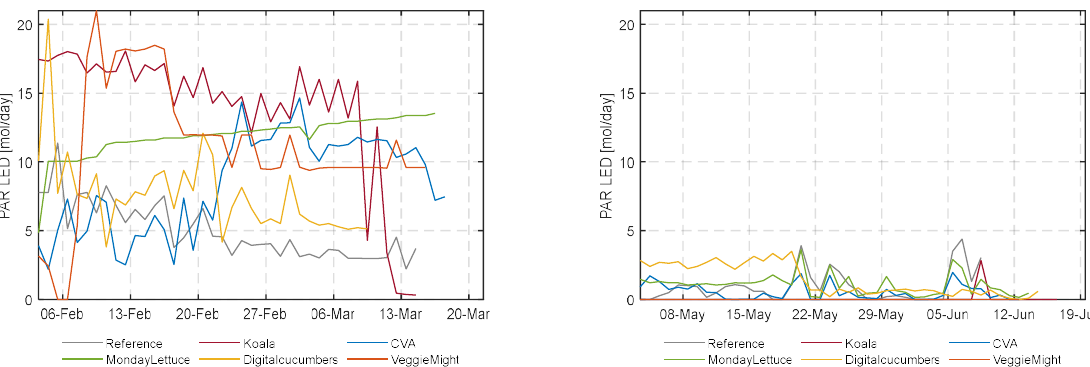
Figure A3. Blackout screen usage in all compartments during the first and second cultivation.